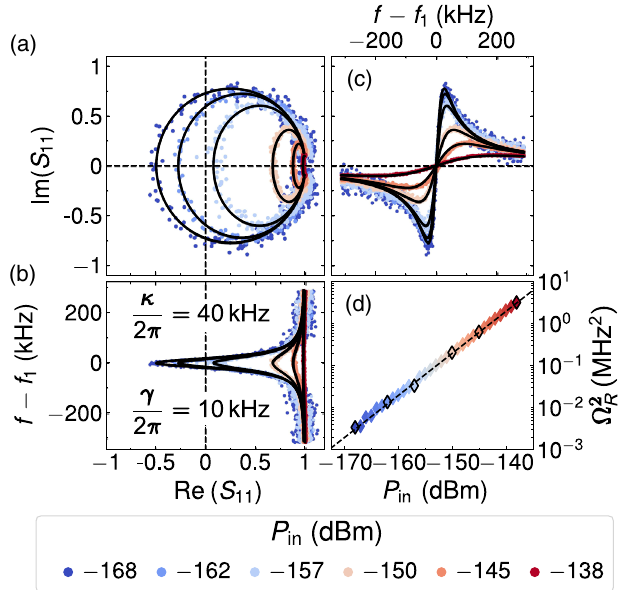
FIG. 2. Resonance fluorescence. (a) Single-port reflection co- efficient S 11 measured around the qubit frequency f 1 ¼ 7 . 4887 GHz. For probe powers P well below the single-photon in regime ( ¯ n ≪ 1 ), S 11 closely resembles a circle in the quadrature plane (dark blue markers), from which, using Eq. (1), we extract the external and internal decay rates κ ¼ 2 π × 40 kHz and γ ¼ 2 π × 10 kHz, respectively. In (b) and (c) we show the real and imaginary part of the reflection coefficient Re ð S 11 Þ and Im ð S 11 Þ , respectively, as a function of the detuning between the probe frequency f and the qubit frequency f 1 . When increasing the probe power P , the response becomes elliptic in the quadrature in plane, which is the signature of resonance fluorescence of a two- level system [35]. The black lines indicate fits to the experimental data according to Eq. (1). The only fitting parameter is the Rabi frequency Ω ; κ and γ are fixed by the fit to the low power R response [cf. panel (a)]. In (d) we show Ω 2 as a function of incident R . For a two-level system, given by the limit on-chip power P in Ω ≪ α , we expect a linear dependence, as confirmed by the black R dashed line passing through the coordinate